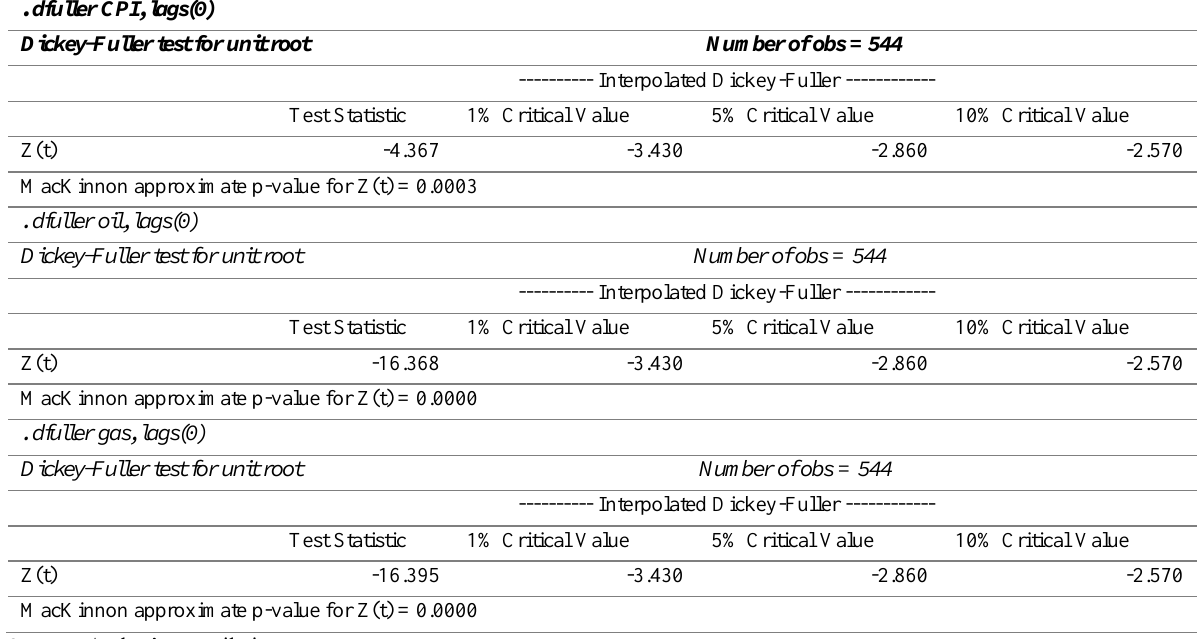
Table 3: Augmented Dickey-Fuller (ADF) test results for unit root of oil, gas and CPI data